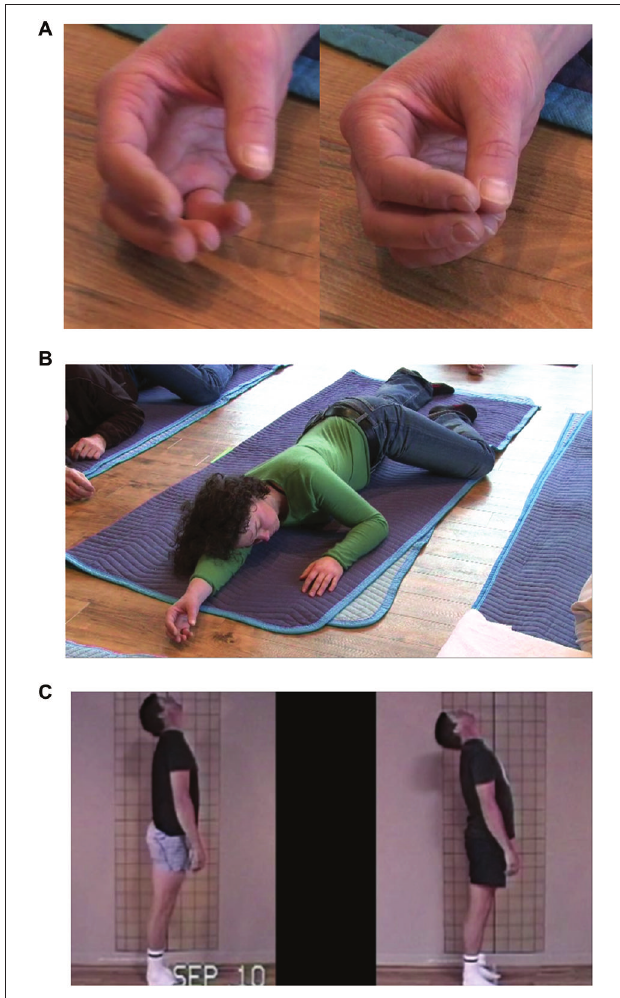
FIGURE 3 | (A) and (B) Frames from Awareness Through Movement (ATM) supplementary videos 2 and 3 demonstrating “motoric mind wandering.”